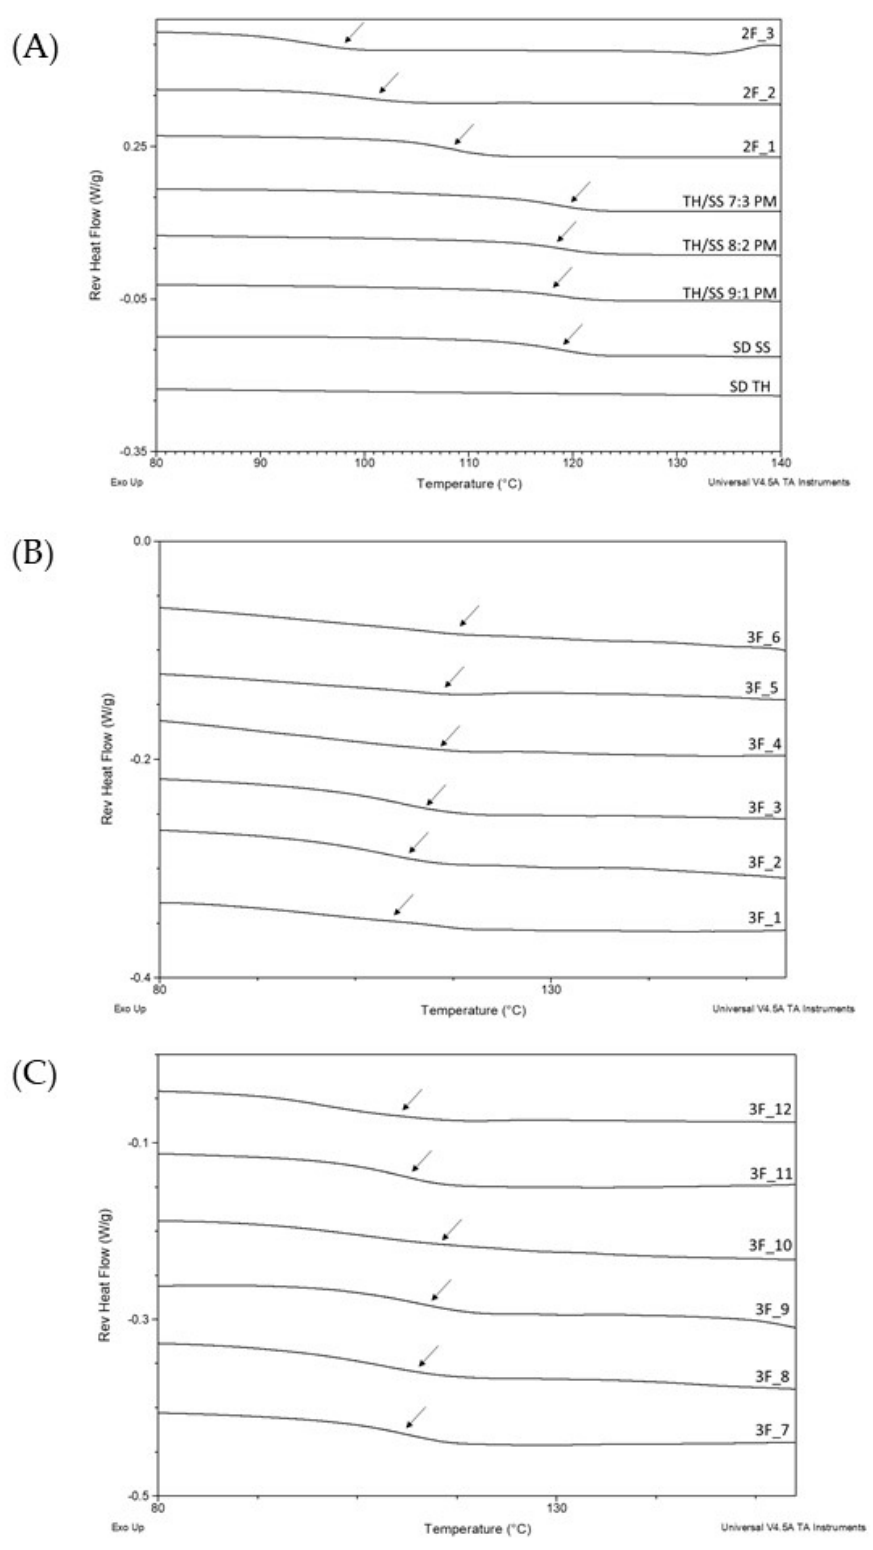
Figure 4. Representative reversible heat flow Modulated Differential Scanning Calorimetry (MDSC) thermograms of powders, including ( A ) spray-dried theophylline; spray-dried salbutamol sulphate, spray-dried SS and TH physical mixture, and samples 2F_1–3; ( B ) samples 3F_1–6; ( C ) samples 3F_7–12. Arrows indicate the mid-point of the T g